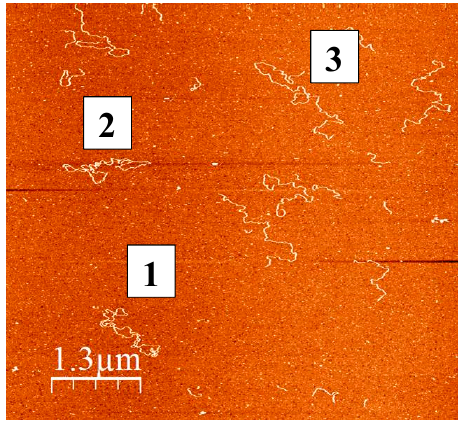
Figure 1. Atomic force microscopy (AFM) image of mitochondrial DNA (mtDNA) isolated from human skeletal muscle (essentially as described by [36]) by phenol extraction. The DNA molecules (0.6 ng/mL) were deposited on freshly cleaved mica in 4 mM HEPES-K (pH 7.4), 2 mM MgCl 2 , and 10 mM NaCl for